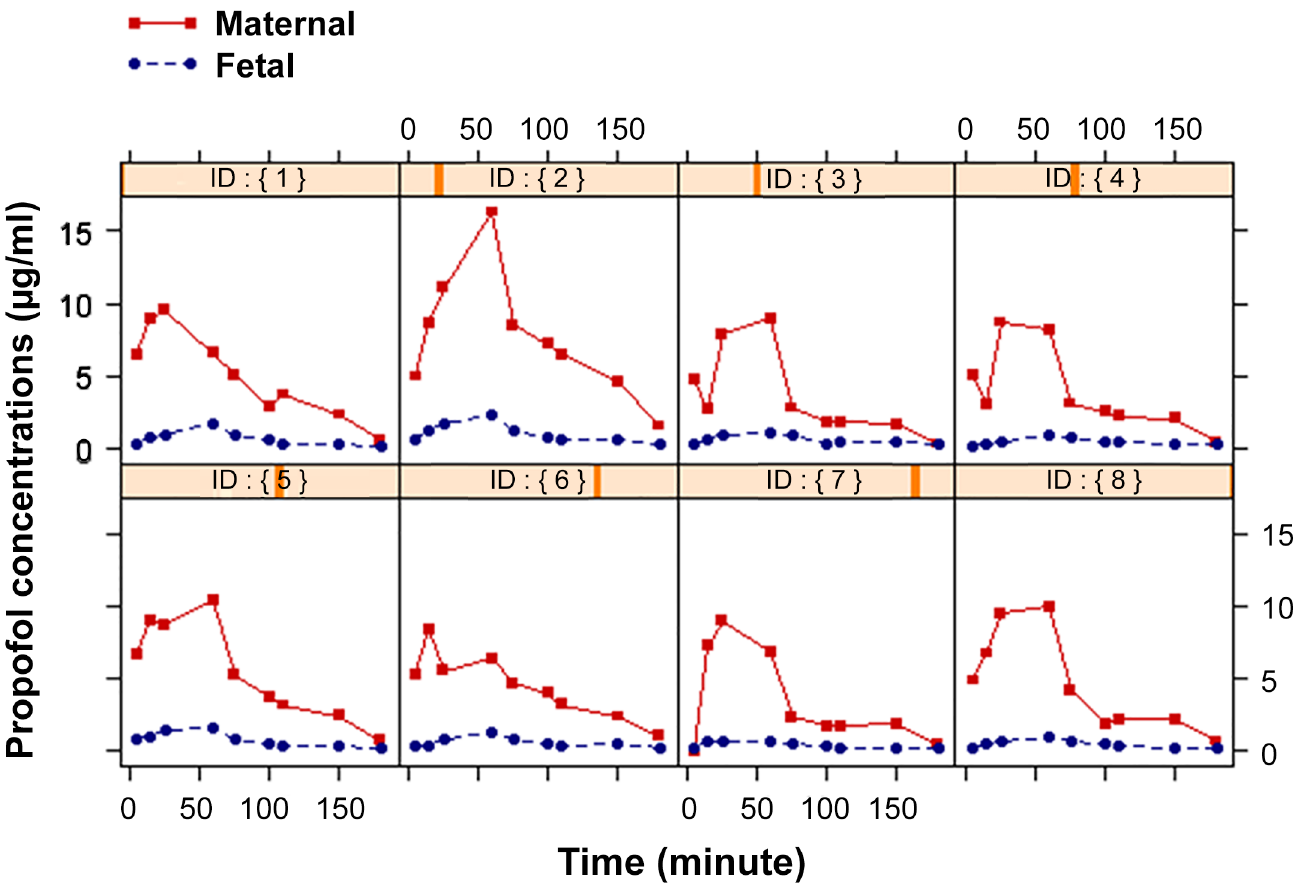
Fig 1. Propofol concentration time profiles for each fetal-maternal sheep unit (n = 8). Propofol was administered to the ewes as a bolus of 3 mg/kg, followed by an infusion of 450 μ g/kg/min for 60 minutes. After that, propofol infusion rate was decreased to 75 μ g/kg/min for 90 more minutes, and then